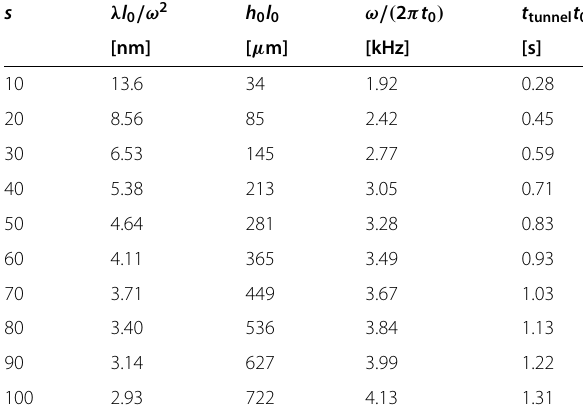
Table 1 Dependence of parameters for the case of a 39 K atom on the size of a discrete time crystal for a hard-wall potential mirror and λ = 0.2, (cid:14) E / J = 10, N b = 54. Gravitational units for